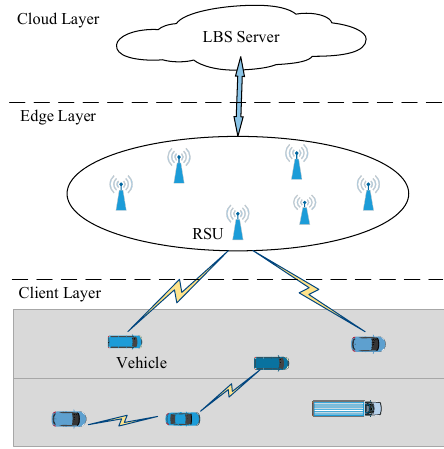
Figure 1. The architecture of an IoV system .